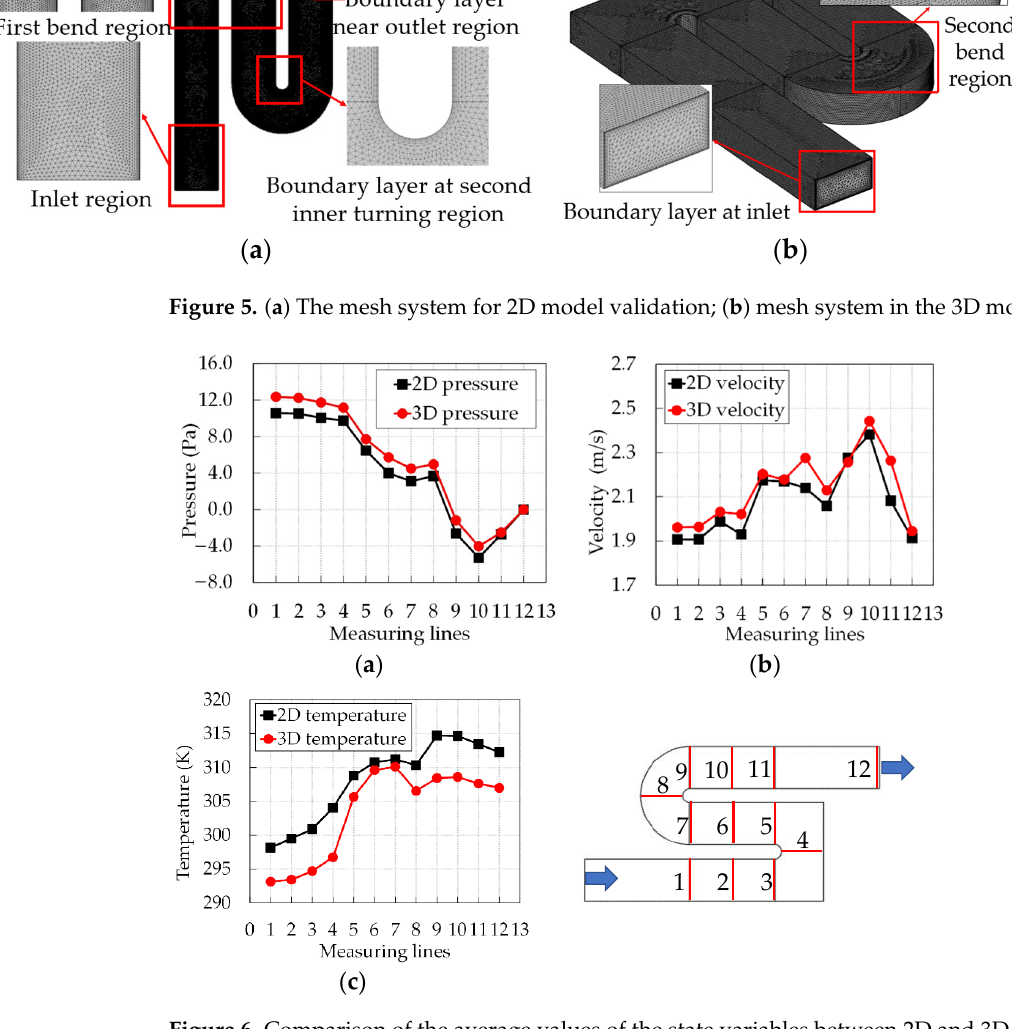
Figure 6. Comparison of the average values of the state variables between 2D and 3D at Re = 10,000: ( a ) pressure values; ( b ) velocity magnitudes; ( c ) temperature values.